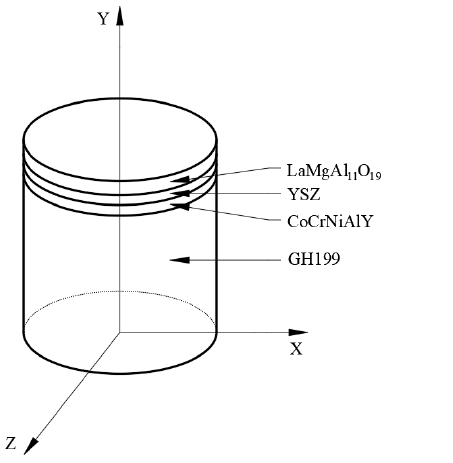
( c ) Figure 2. Two-dimensional finite element physical model: ( a ) M1, ( b ) M2S1, ( c ) M2S2. 2.2.2. Material Parameters and Basic Assumptions The elastic modulus E, thermal expansion coefficient α , thermal conductivity λ , spe- cific heat capacity C, density ρ , and Poisson’s ratio υ of the material are listed in Table 4 [25–33]. To facilitate the calculation, the following assumptions were considered in the model: 1.